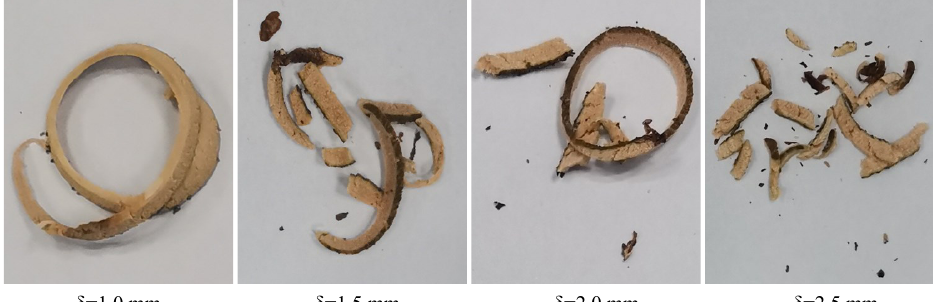
Figure 13. The chips obtained at different bark consumption settings.